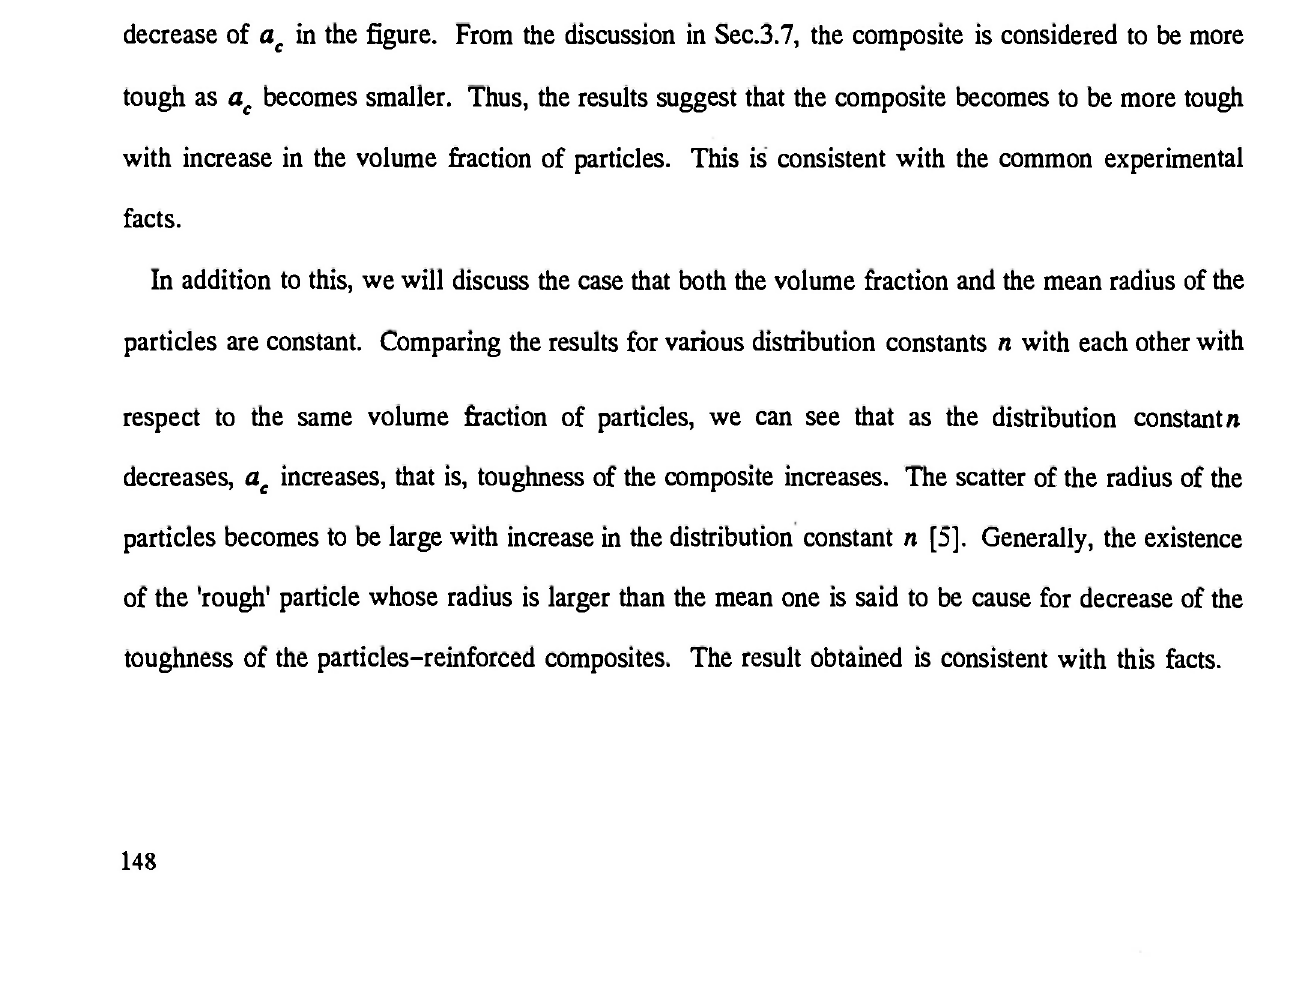
Fig.5 Total energy release rates both for a matrix crack G' a and a debonding crack G' d .